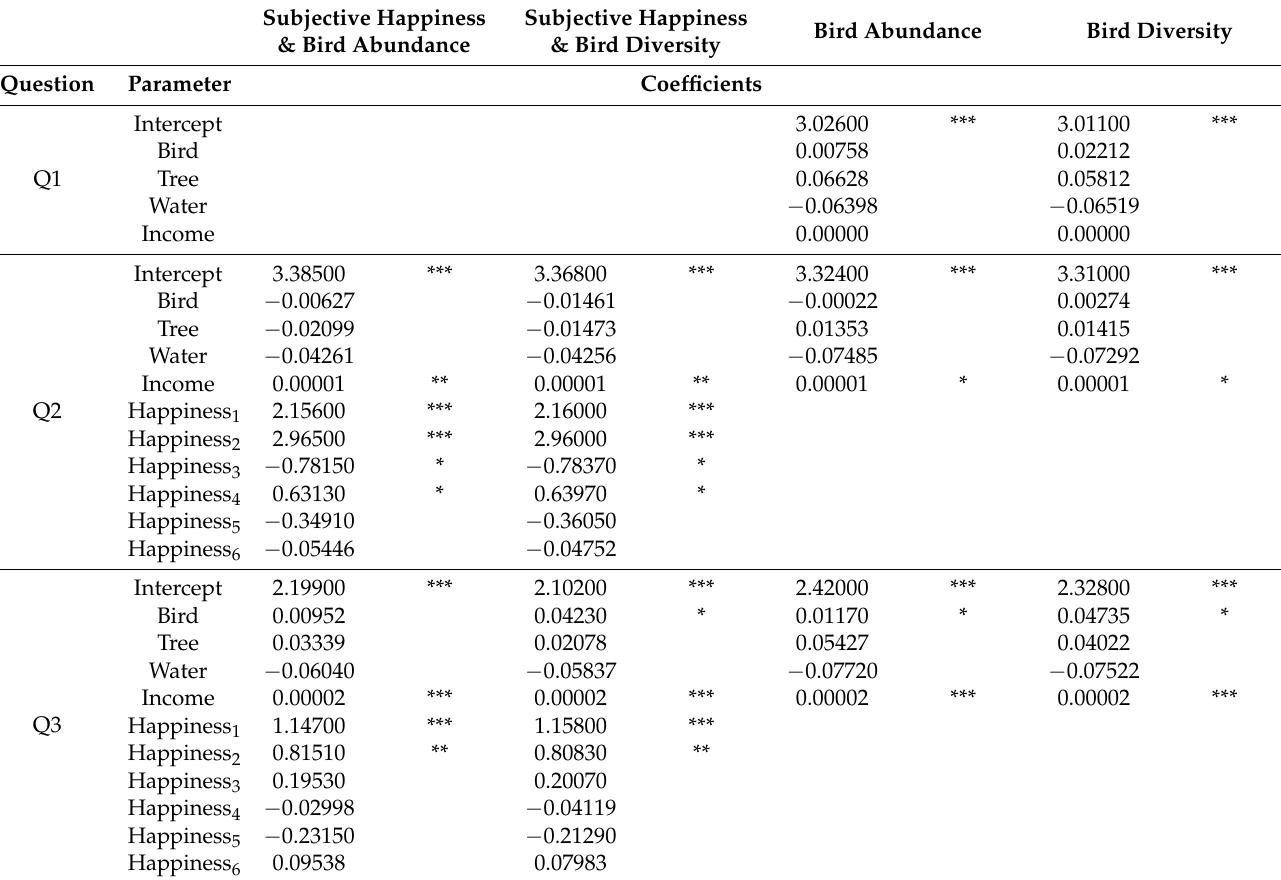
Table A2. Parameter coefficients for all models. Models were fit using ordered probit mixed models where site was treated as a random effect. Predictor variables included bird abundance and diversity, tree canopy cover (ha), distance to water (km), median individual yearly income and subjective happiness (taken from participants’ responses to Question 1 (Table 1)). Models either included subjective happiness as a predictor or did not. If subjective happiness was included as a predictor it was coded using orthogonal polynomial contrasts up to the sixth power. Each model only included one bird variable at a time, either bird abundance or bird diversity (number of species). Significance level is denoted by asterisks: * p < 0.05, ** p < 0.01, *** p <